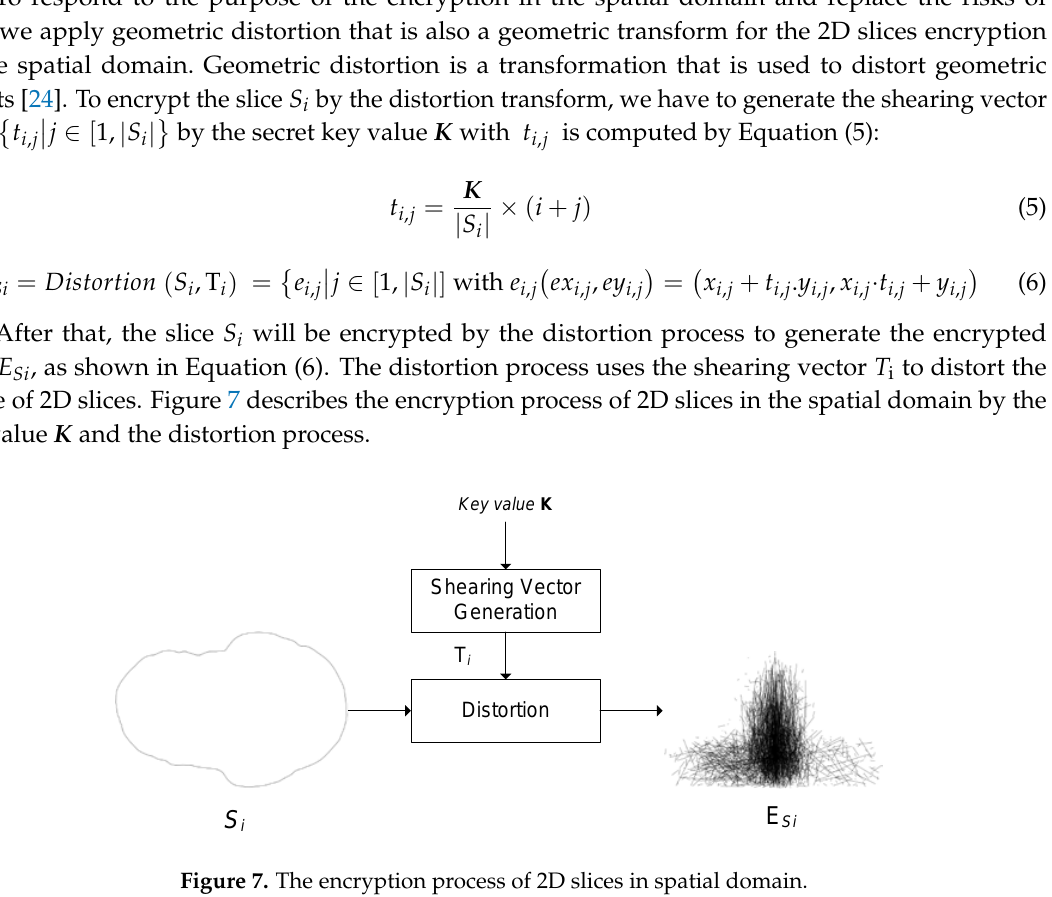
( b ) Figure 8. ( a ) Decryption in the frequency domain, and ( b ) Decryption in the spatial domain .